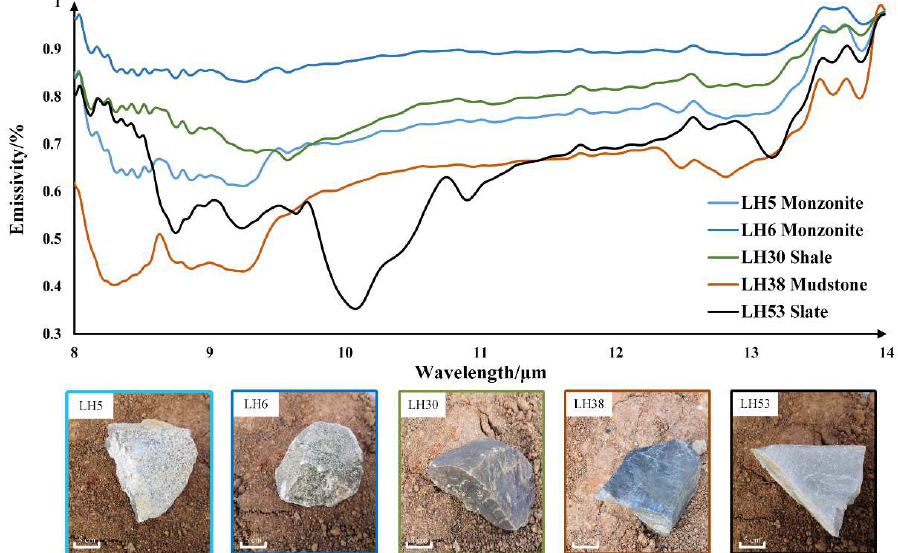
Figure 11. TIR spectral curves and optical images of samples for model verification.